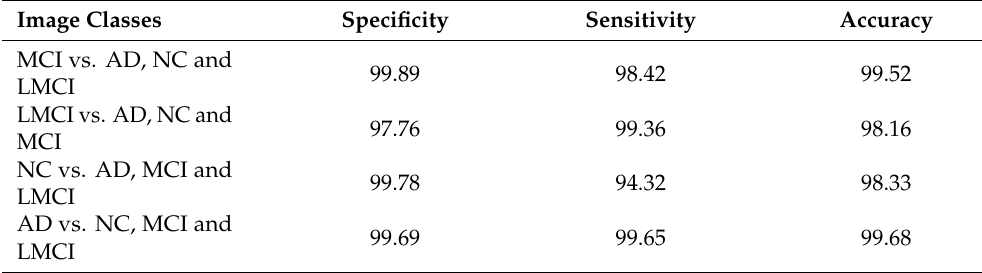
Table 4. Class-wise performance comparison of proposed model.